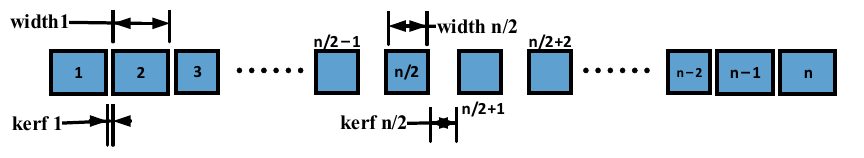
Figure 1. An example of a linear array. While numerical values and the distribution of variables remain to be further studied, we can easily designate three types of arrays from these acknowledged structural parame- ters. Here, three combinations of the parameters shown in Figure 2 were chosen to verify the tendency of the sound field of the MNULA [8].